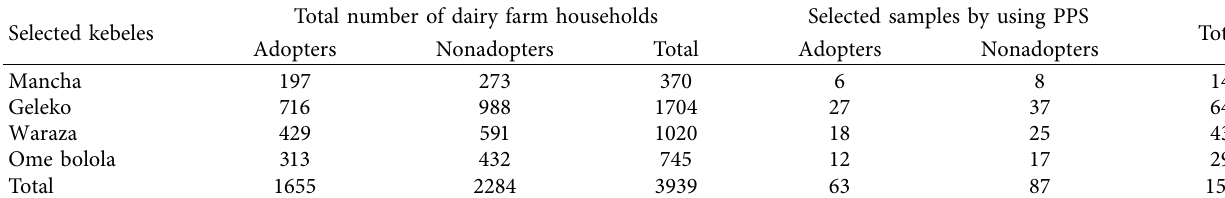
Table 1: Determination of sample households in the study kebeles.